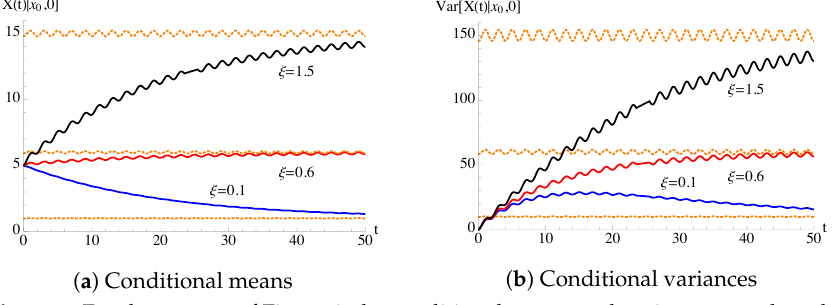
Figure 1. For the process (44), with x 0 = 5, α = − 0.05, ξ = 1.5 and r ( t ) = 0.5 transition densities are plotted. The dotted functions indicate the corresponding asymptotic densities.